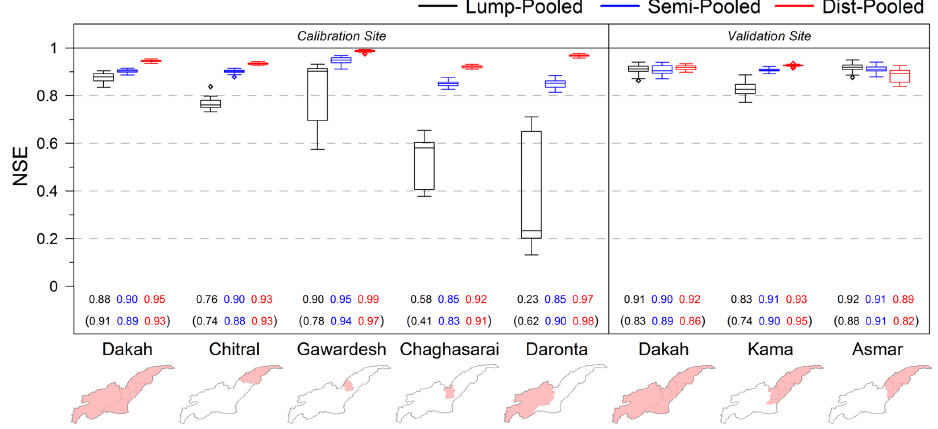
Figure 7. Comparison of the pooled calibrations for the 3 parameterizations of lumped, semi-distributed, and distributed. Each calibration is conducted 50 times. Values on the bottom represent expected values of NSE (in upper row) and KGE (within parenthesis in lower row) from 50